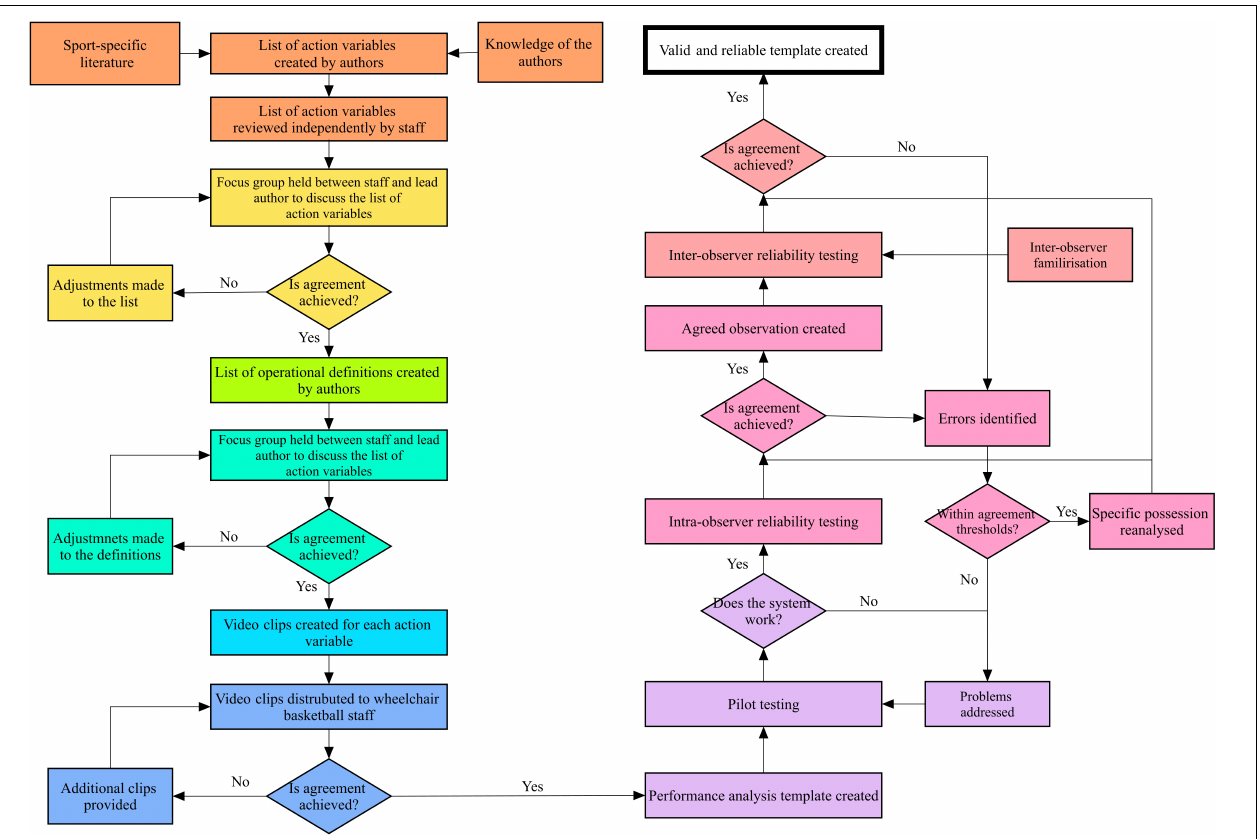
FIGURE 1 | Diagram showing the systematic research process for developing a new performance analysis template [adapted from James et al. (2005) and Thomson et al.